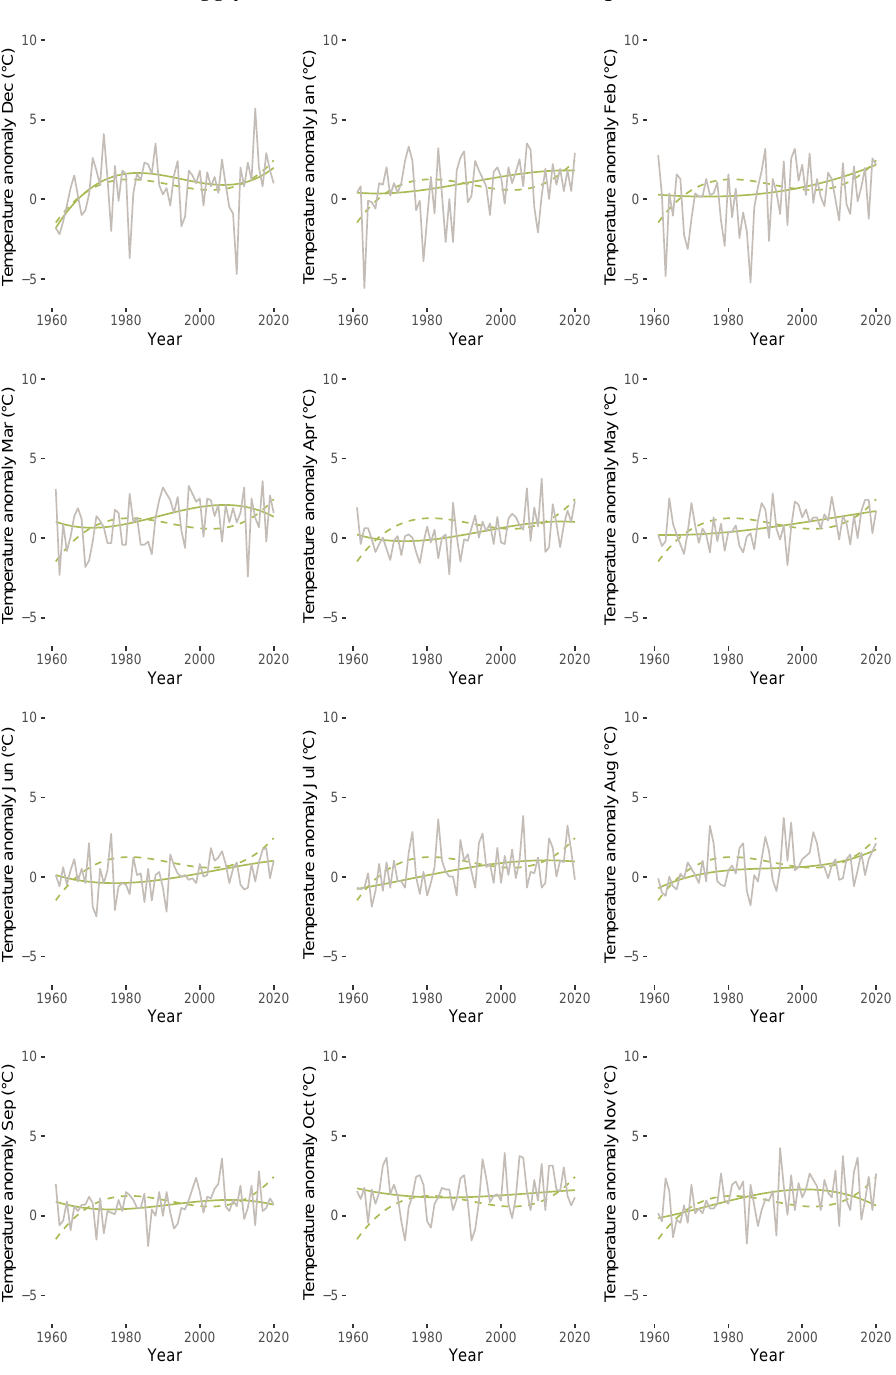
Figure 9. Estimated trend polynomial of degree three by quantile regression ( τ = 0.5; solid green line) and least squares regression (dashed green line) for anomalies for each month from January 1961 until December 2020 (grey